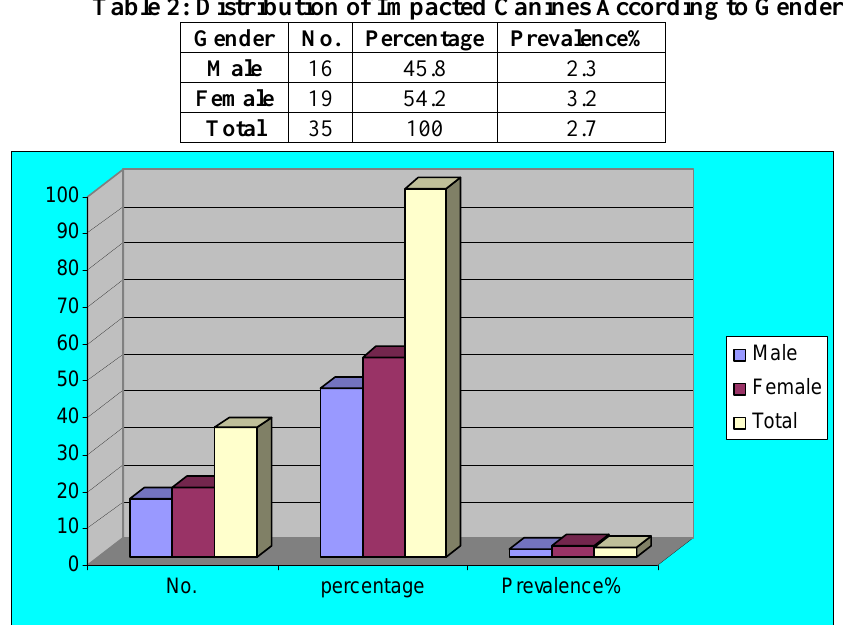
Table 2: Distribution of Impacted Canines According to Gender